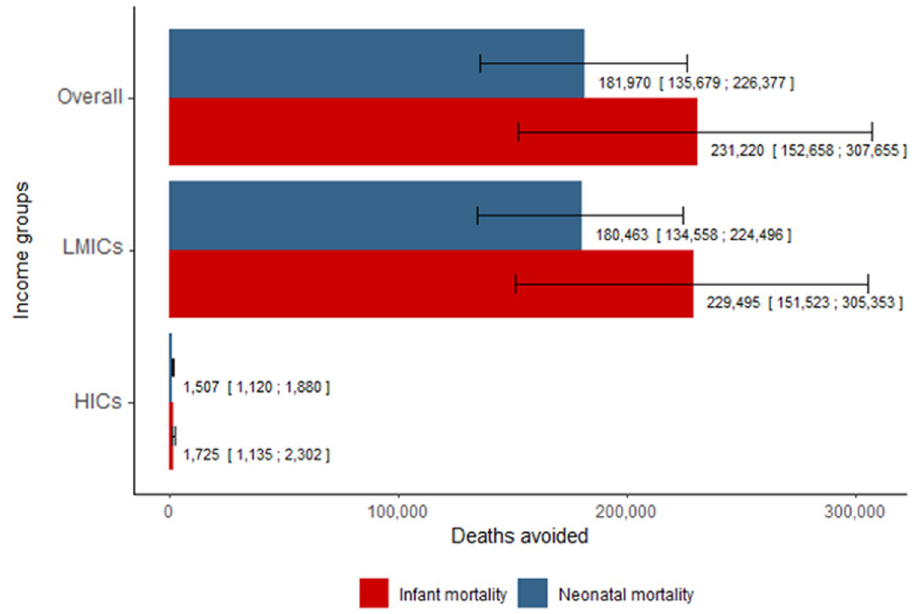
Fig 2. Neonatal and infant deaths averted by raising taxes to 75% by income group (number of deaths and 95% CI). Abbreviations: VAT = value-added tax; HICs = High-income countries; LMICs = Low- and middle-income